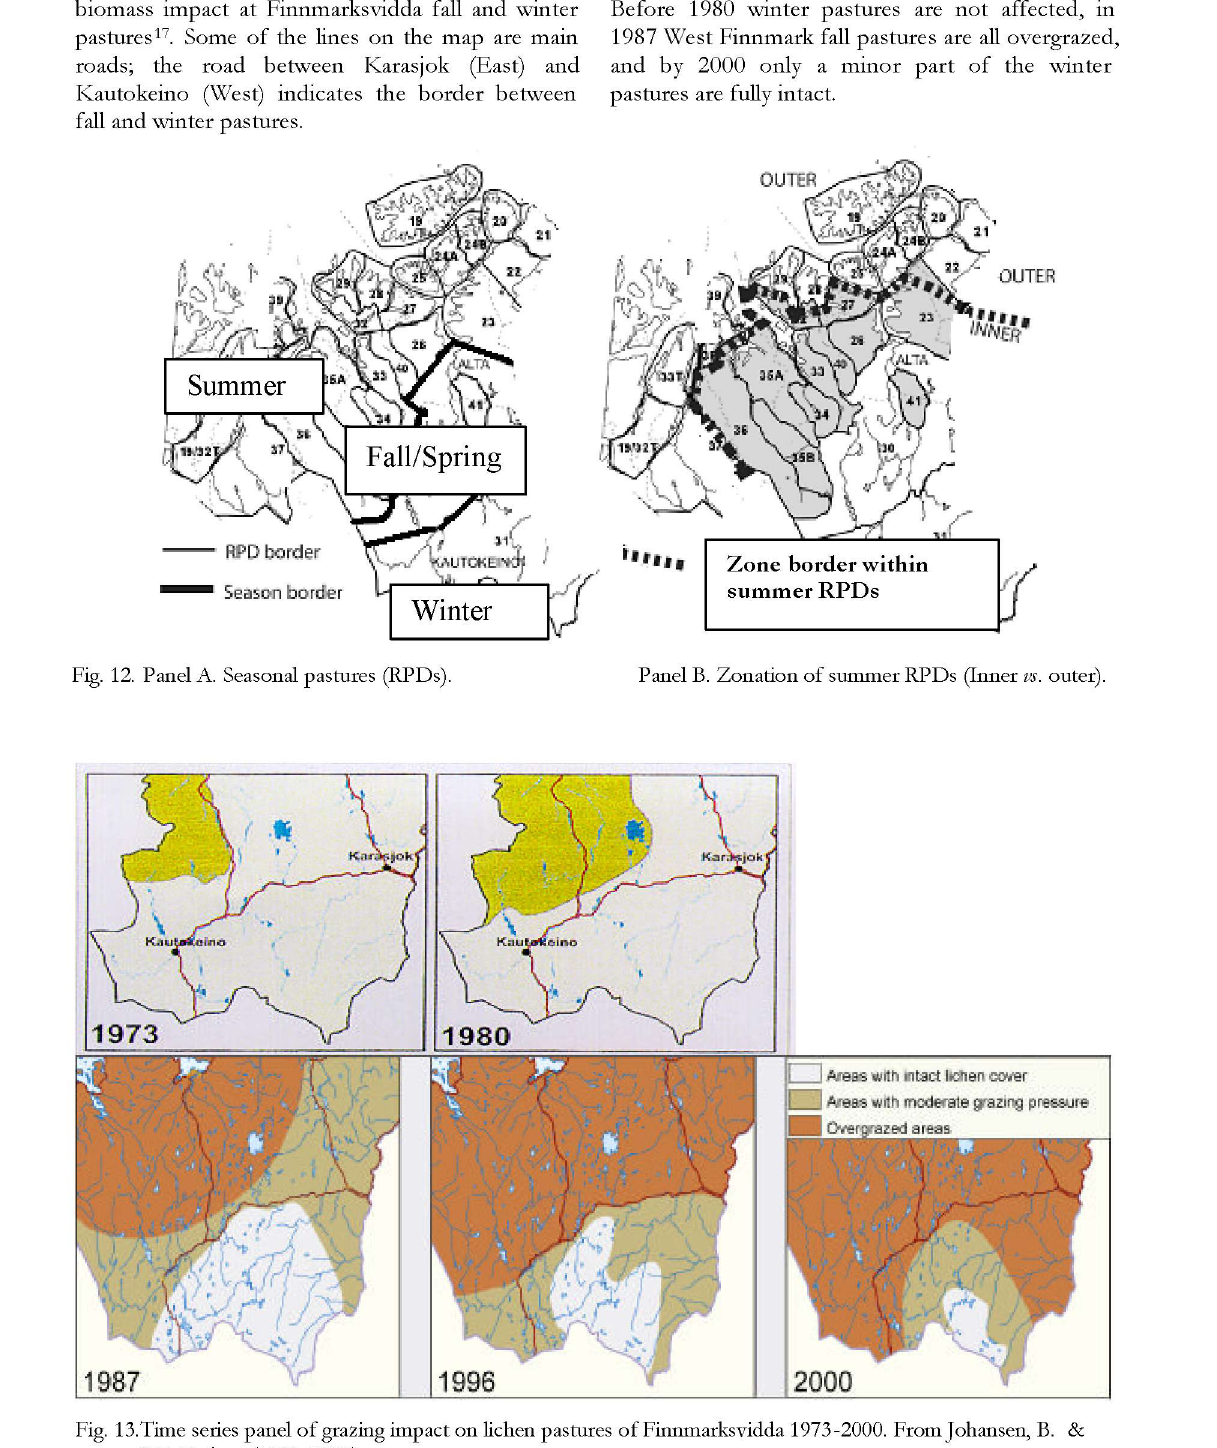
Fig. 12. Panel A. Seasonal pastures